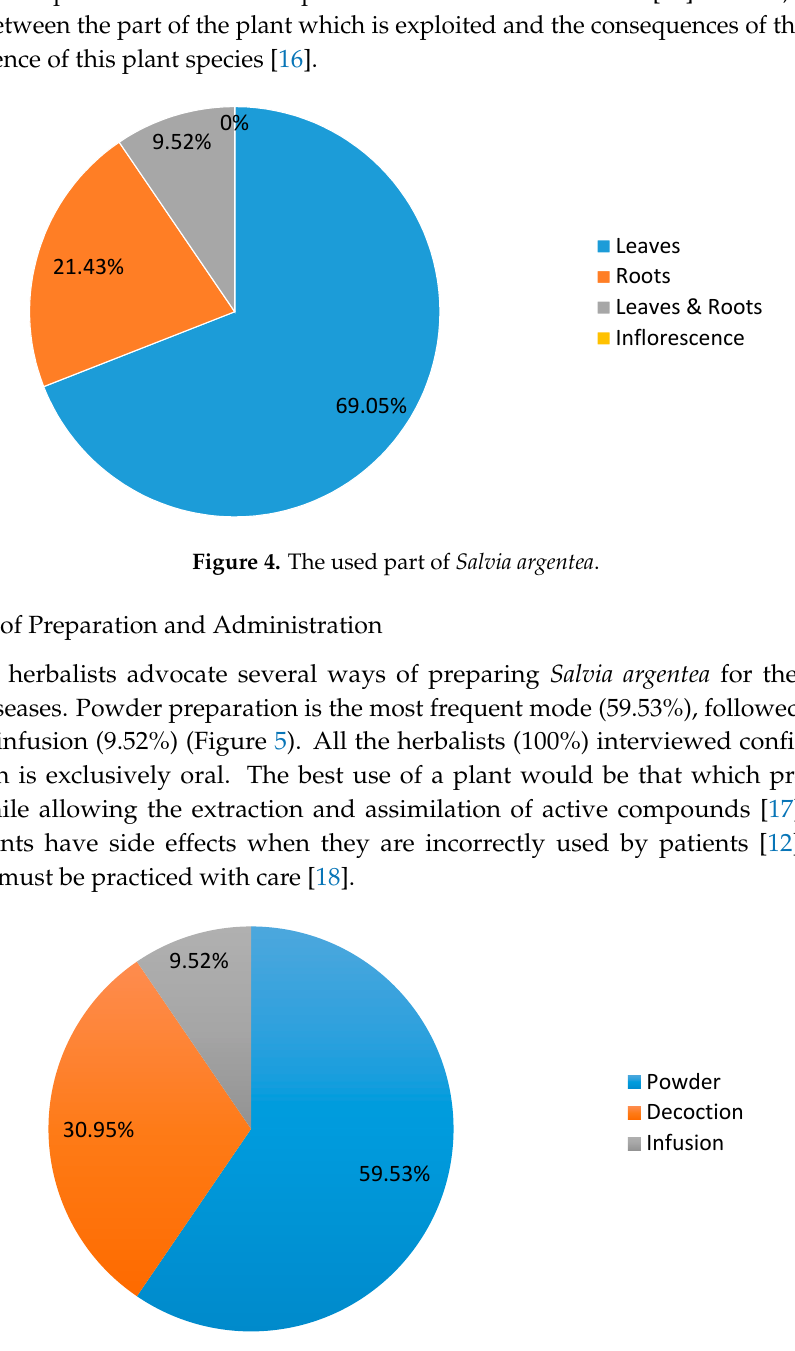
Figure 5. Method of preparation.